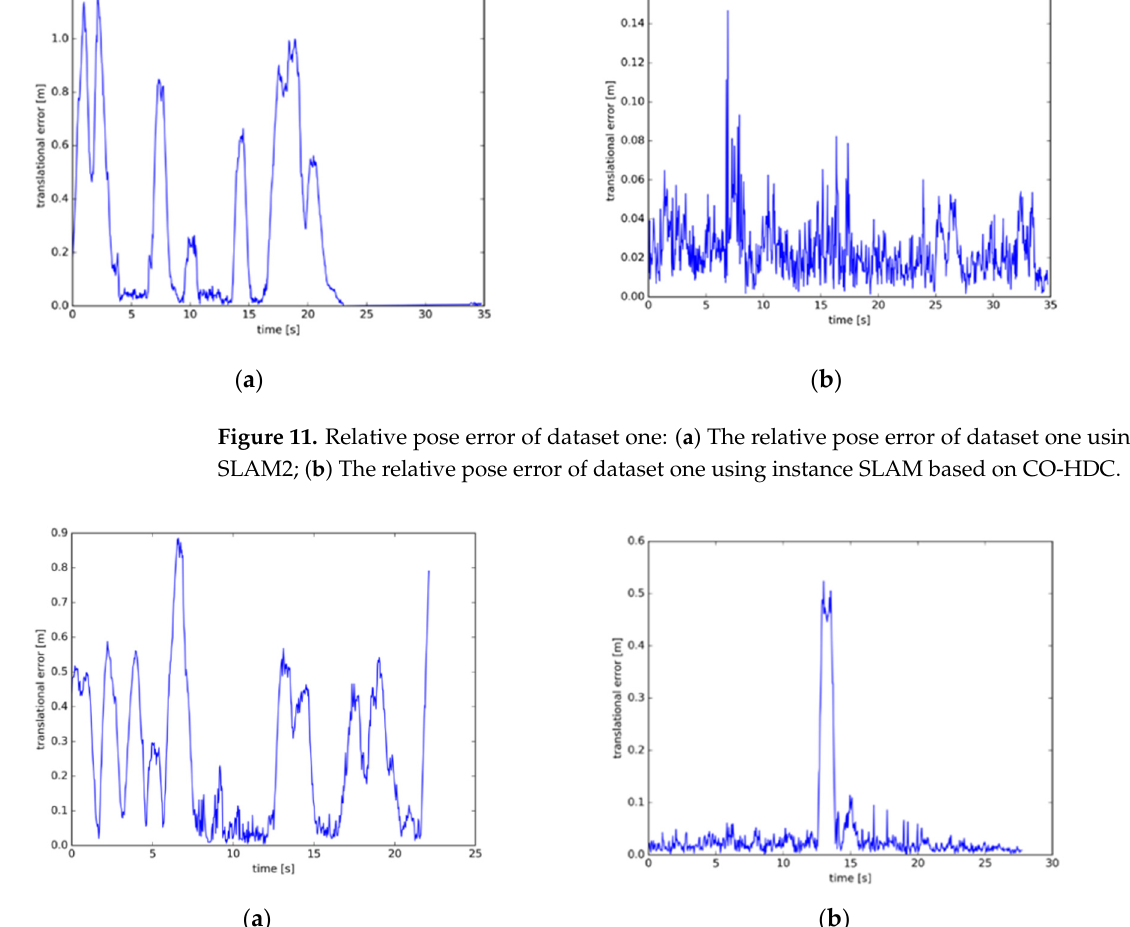
Figure 12. Relative pose error of dataset two: ( a ) The relative pose error of dataset two using ORB-SLAM2; ( b ) The relative pose error of dataset two using instance SLAM based on CO-HDC.